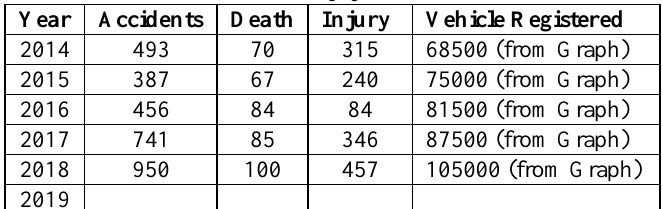
Table 3: Vehicle Population (Approx.) and road crash data by year.